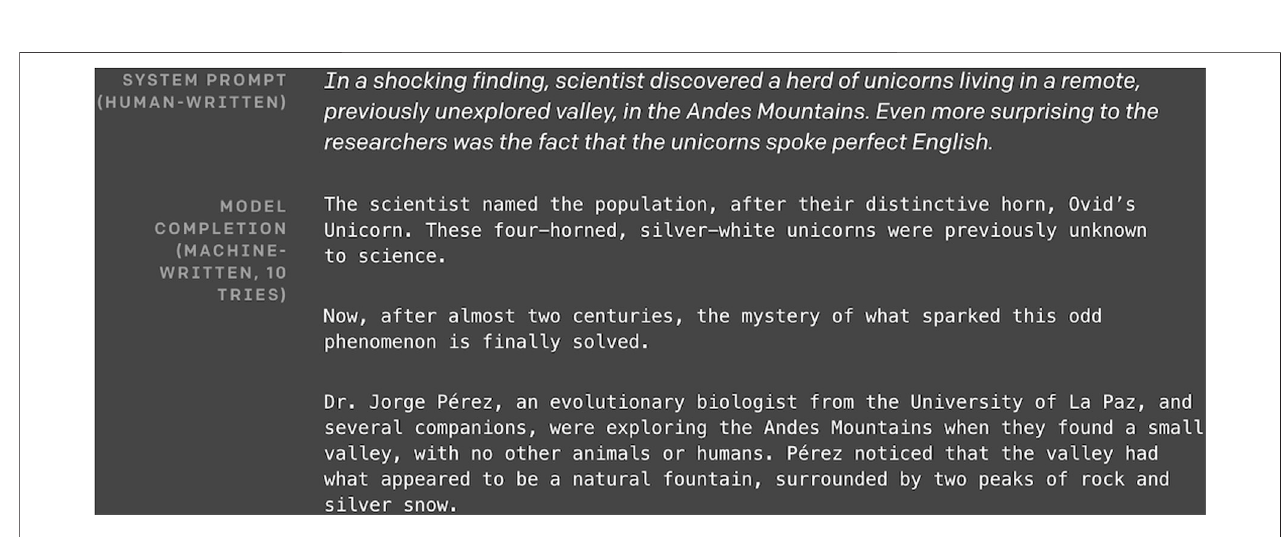
FIGURE 2 | Sample text generated by Generative Pre-trained Transformer 2 (GPT-2), a large-scale open-source generative language model created by OpenAI (Radford et al., 2019).